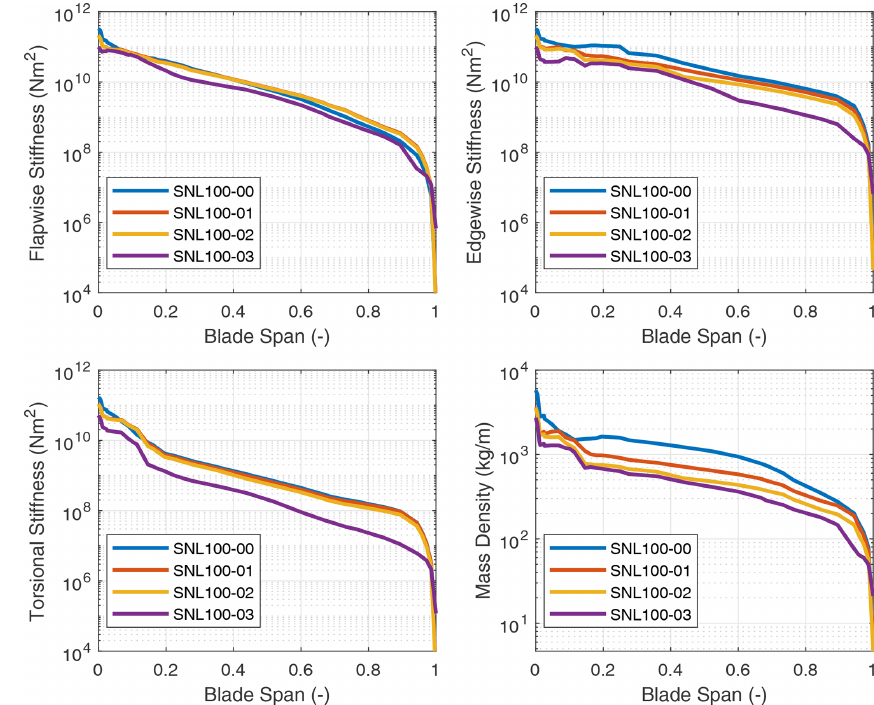
Figure 6. Flapwise stiffness, edgewise stiffness, and mass properties for the SNL100-XX series of blades. Table 5. Flutter speeds for two-bladed wind turbine models. E = edgewise, F = flapwise, T = torsional. The numbers next to the mode type indicate the mode order. The modes are arranged according to highest to lowest contribution. Turbine No. of Blade Rated First unstable edgewise mode First classical flutter mode blades length rpm rpm Nature Transition rpm Nature